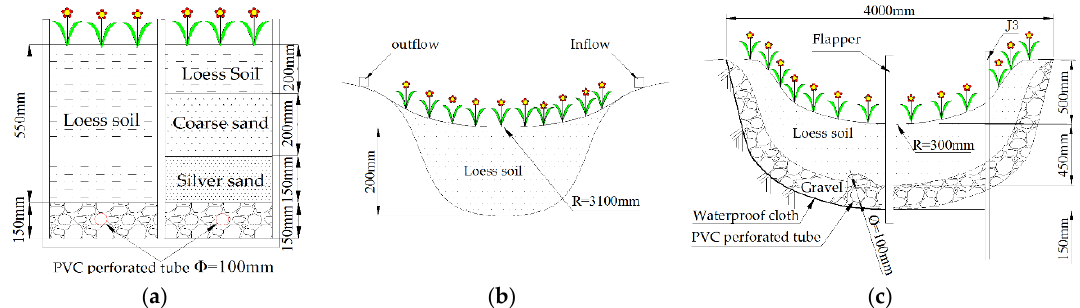
Figure 3. Rain garden structure. Note: Rain garden No. 1 is composed of two parts with different filter media and is used to monitor the inflow, outflow, and the pollutant concentration; rain garden No. 2 is a permeable rain garden without outflow and is used to monitor the inflow and overflow; rain garden No. 3 is divided into two sub-sections and is used to compare the runoff volume reduction and pollutant purification effect with different structures. ( a ) Rain garden No. 1; ( b ) Rain garden No. 2; ( c ) Rain garden No. 3.